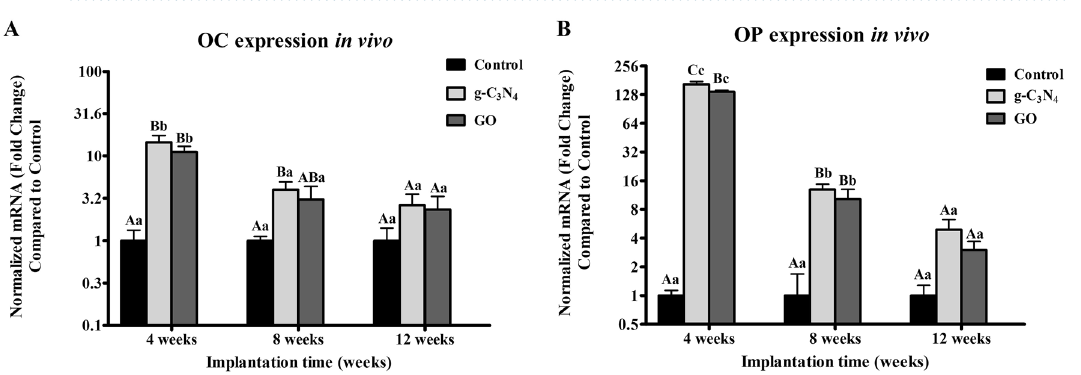
Figure 7. In vivo qRT-PCR analysis. q-PCR analysis for mRNA expression of osteocalcin (OC) ( A ) and osteopontin (OP) ( B ) in different groups at week 4,8, and 12 post-implantations. Error bars ± SD; n = 3 for each group and time point. Bars with the same letter represent values that are not significantly different (two-way ANOVA followed by Tukey’s HSD post hoc test). ( A – C ) significance between groups; a, b, and c: significance between time